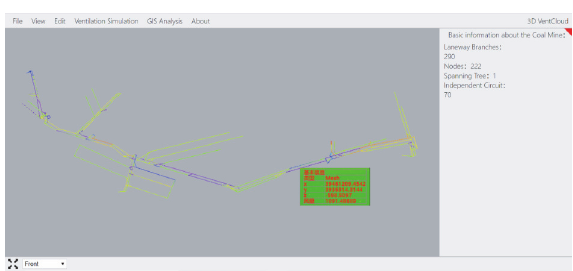
Figure 9: The 3D visualization of mine ventilation simulation result.